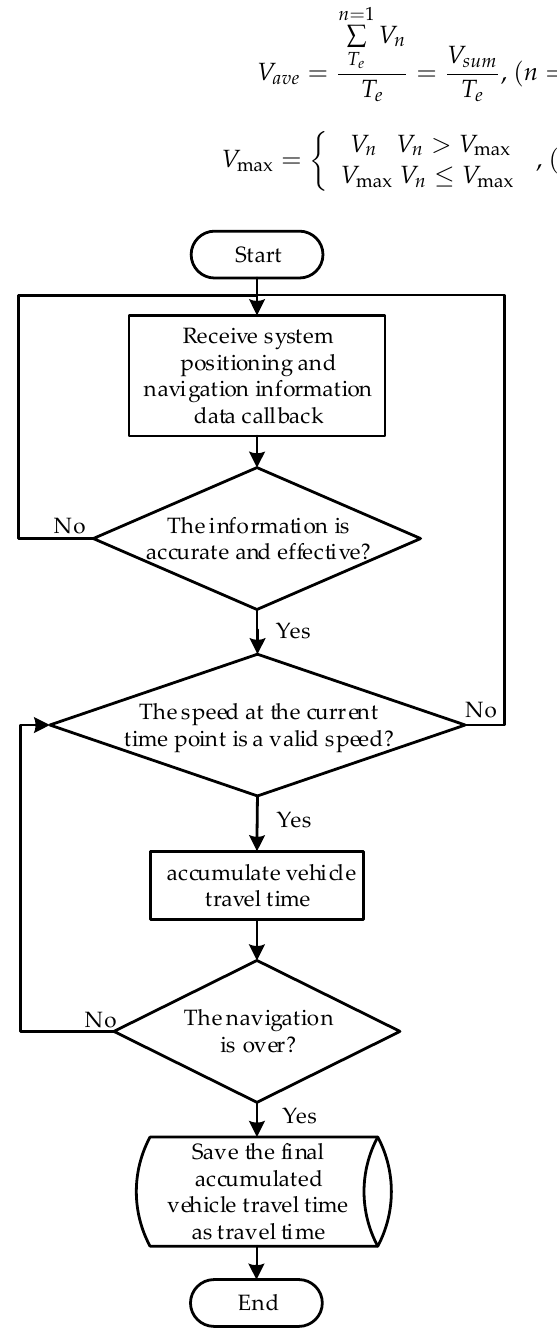
Figure 3. Flow chart of travel time T e acquisition algorithm .